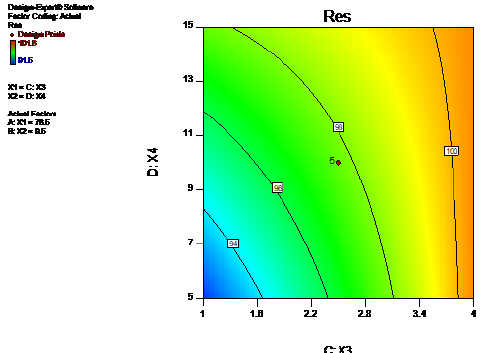
Figure 3. Contourlines for dependence of ON on variables X3 and X4 for linear